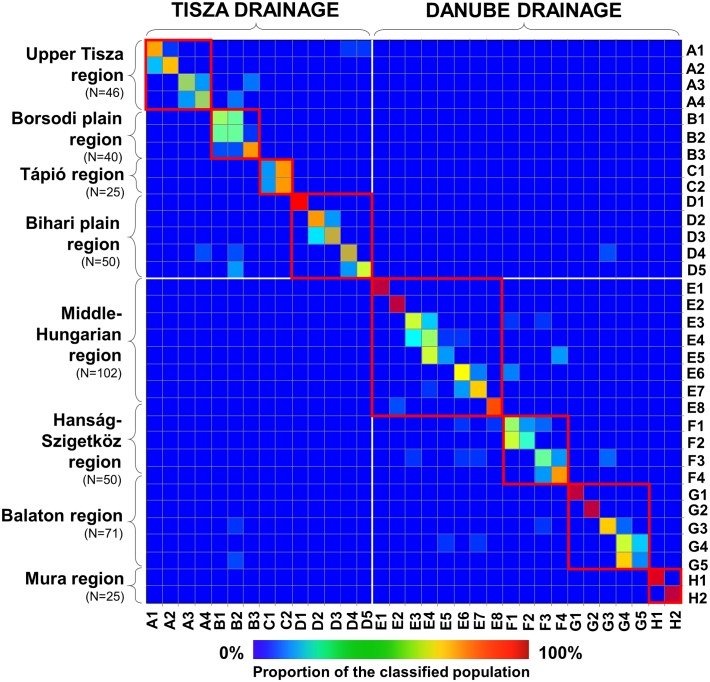
Plots of the Bayesian cross-validation test for microsatellite data.Correctly classified individuals are placed on the diagonal. The square colour corresponds to the proportion of individuals of posterior group assignment based on posterior probabilities. Rows correspond to actual sites (a priori), while columns correspond to inferred sites (posteriori). White thick lines separate the Tisza and Danube drainage basins, red rectangles show the regional detachments of populations. Codes of sites correspond to Table 1.